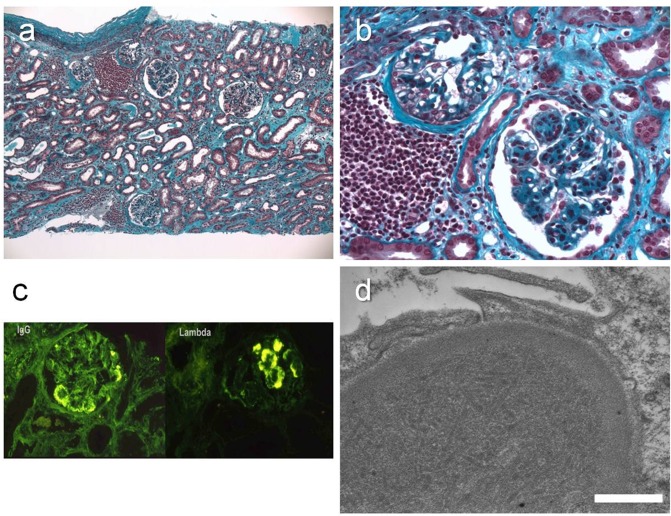
GOMMID (case 15) (a) Light microscopy.Masson trichrome. Mesangial sclerosis with focal mesangial proliferation. Note mild monomorphic focal CLL/SLL infiltrate. Original magnification, X 10. (b) Light microscopy. Masson trichrome. Mesangial sclerosis and proliferation, capillary deposits. Original magnification, X 40. (c) Immunofluorescence microscopy. Monotypic Ig lambda deposits. The same fluorescence patern was obtained with an anti-C3 antibody (data not shown). (d) Electron microscopy. Subendothelial organized microtubular deposits, 30-nm external diameter. Bar = 1200 nm.